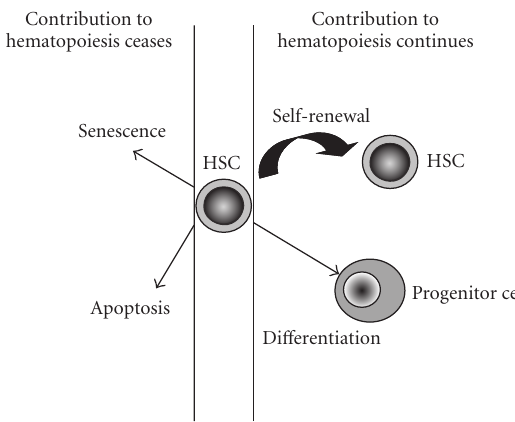
Figure 1: Hematopoietic stem cells (HSCs) undergo fate decisions including self-renewal (resulting in the production of more HSCs), di ff erentiation (producing more mature progenitor cells), senes- cence, or apoptosis, the latter two resulting in cell